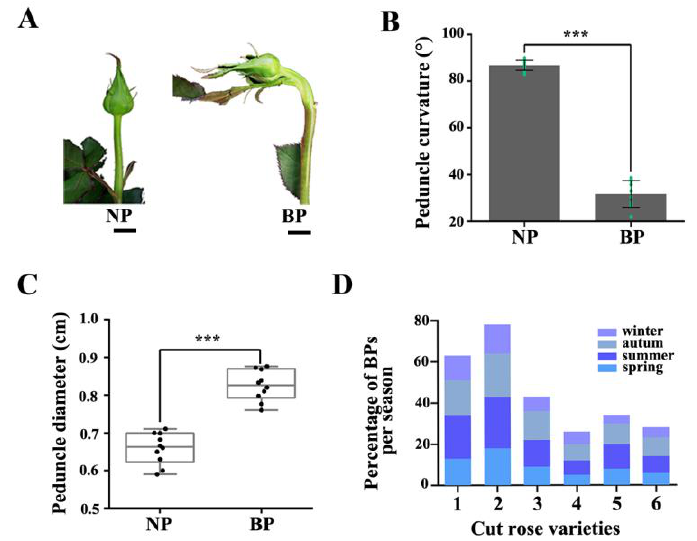
Figure 1. Characteristics of BPP. ( A ) Phenotypes of normal peduncle (NP) and bent peduncle (BP) at developmental stage 1. Scale bar = 10 mm. ( B ) Angles of NP and BP in the horizontal direction. ( C ) Statistics for the diameters of NP and BP. Error bars indicate standard deviation (SD). Ten biological replicates were performed for B and C ( n = 10). Asterisks denote statistically significant difference determined by using Student’s t -test (*** p < 0.001). ( D ) Percentage of BPs per season of six rose